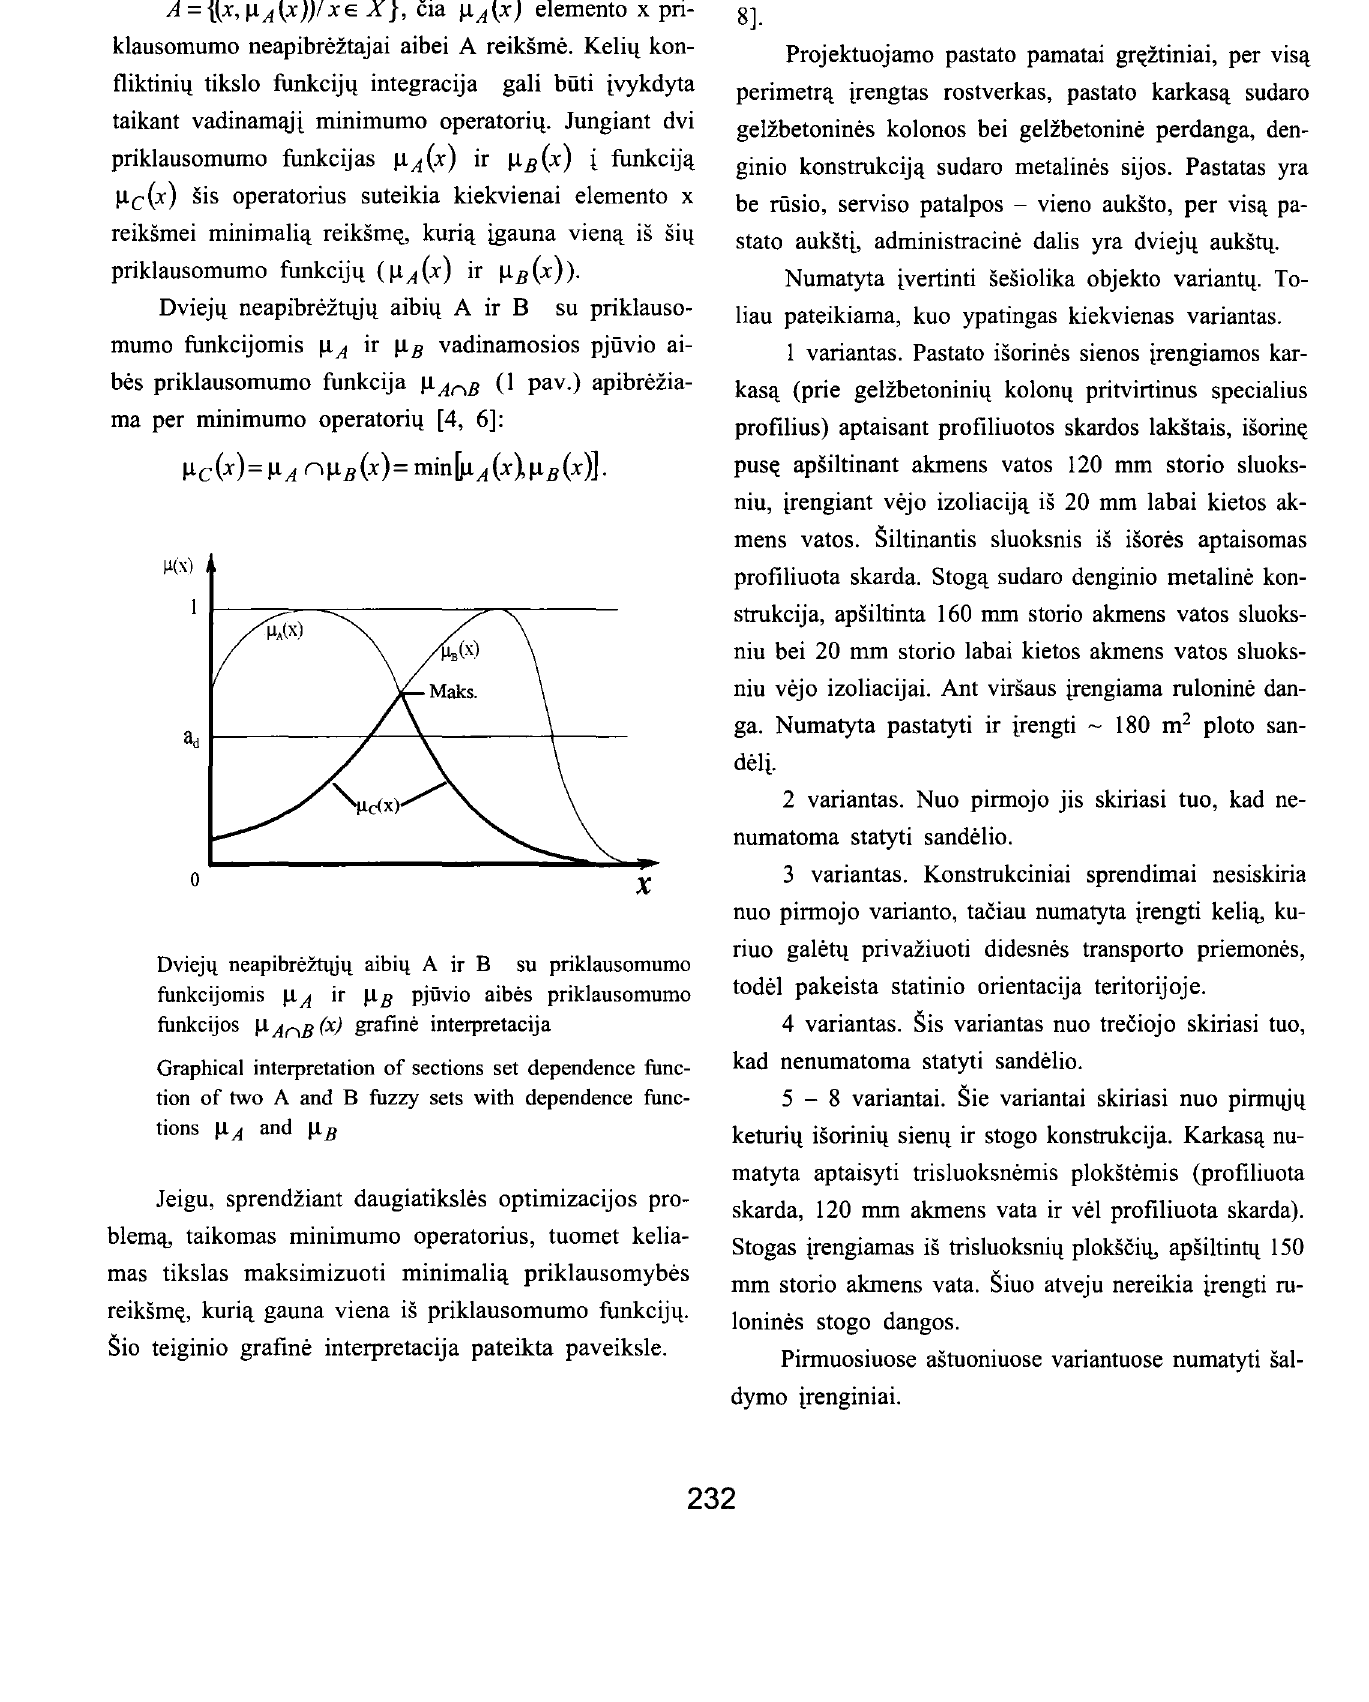
k1ausomumo neapibreztajai aibei A reiksme. Keliq kon fliktinitt tikslo funk:cijtt integracija gali buti ivykdyta taikant vadinamltii minimumo operatoritt. Jungiant dvi